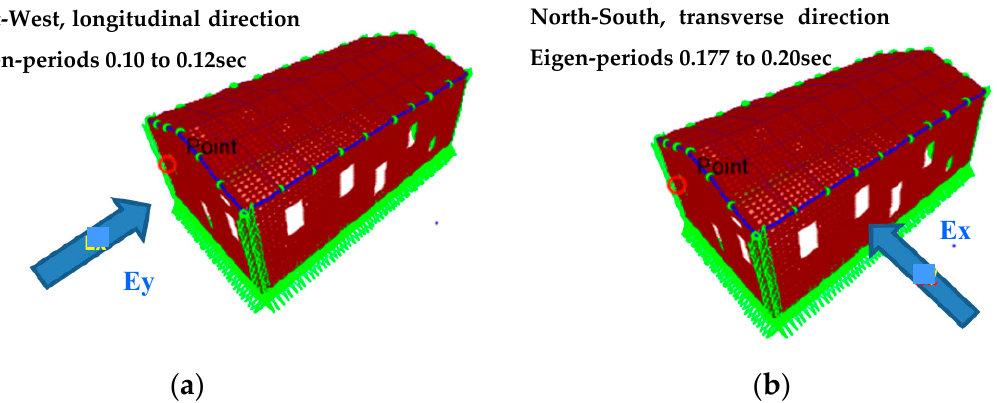
Figure 14. The numerical simulation of the “Basilica” church of St. Marina in Soullaroi in Kefalonia. ( a ) Longitudinal direction; ( b ) Transverse direction.